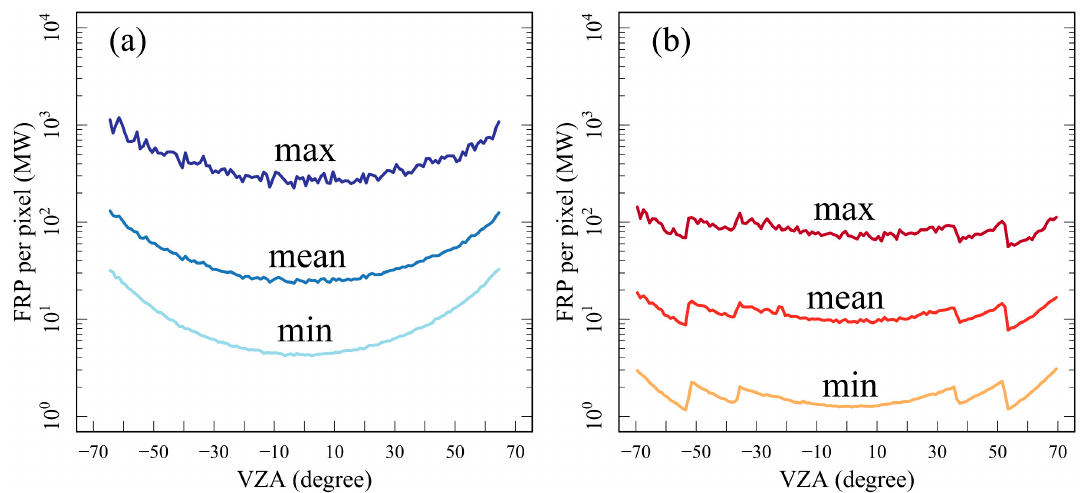
Figure 4. Variations of the minimum (min), mean, and maximum (max) fire radiative power (FRP) per fire detection (or pixel) of the MODIS ( a ) and VIIRS ( b ) sensors in different satellite view zenith angles (VZAs) from nadir to the scan edge. Note that the y -axis is on a logarithmic scale.